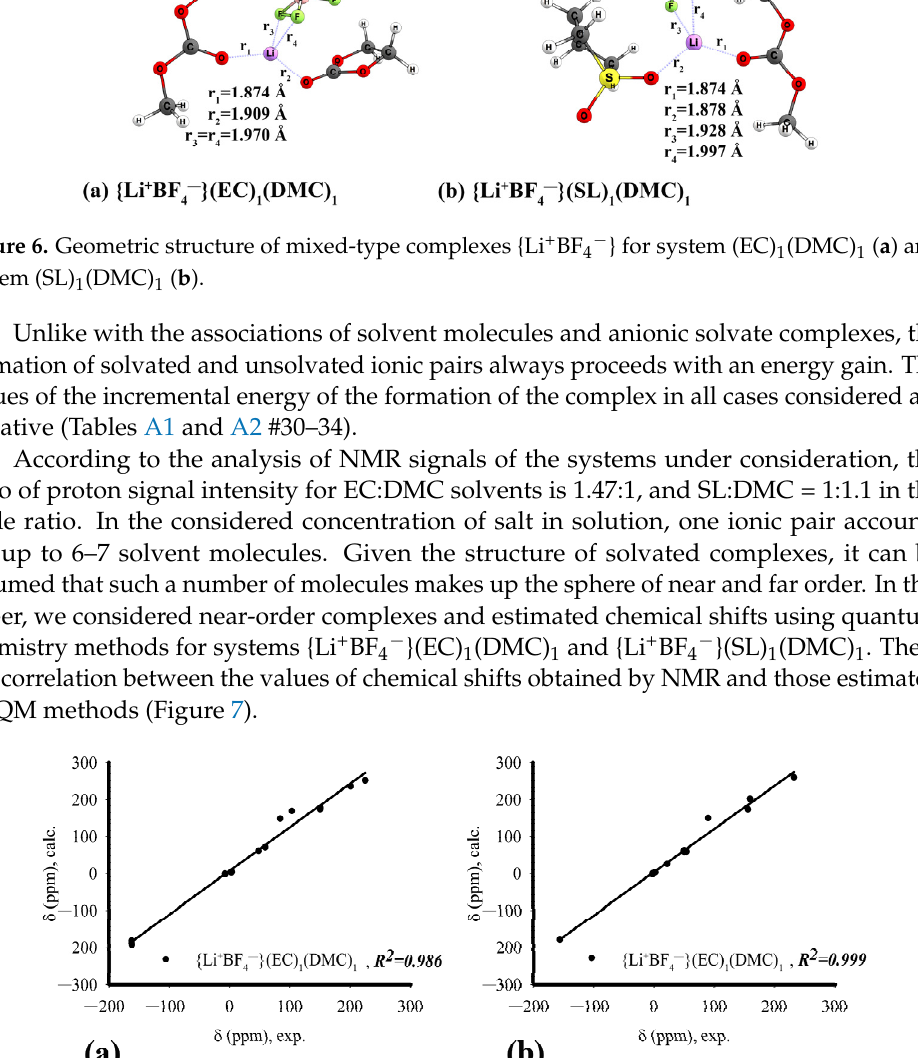
Figure 6. Geometric structure of mixed-type complexes {Li + BF 4 − } for system (EC) 1 (DMC) 1 ( a ) and system (SL) 1 (DMC) 1 ( b ).